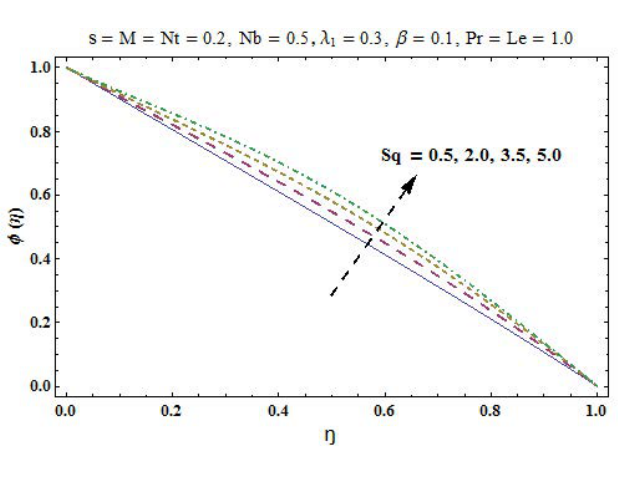
Figure 13. Plots of φ ( η ) for S q .